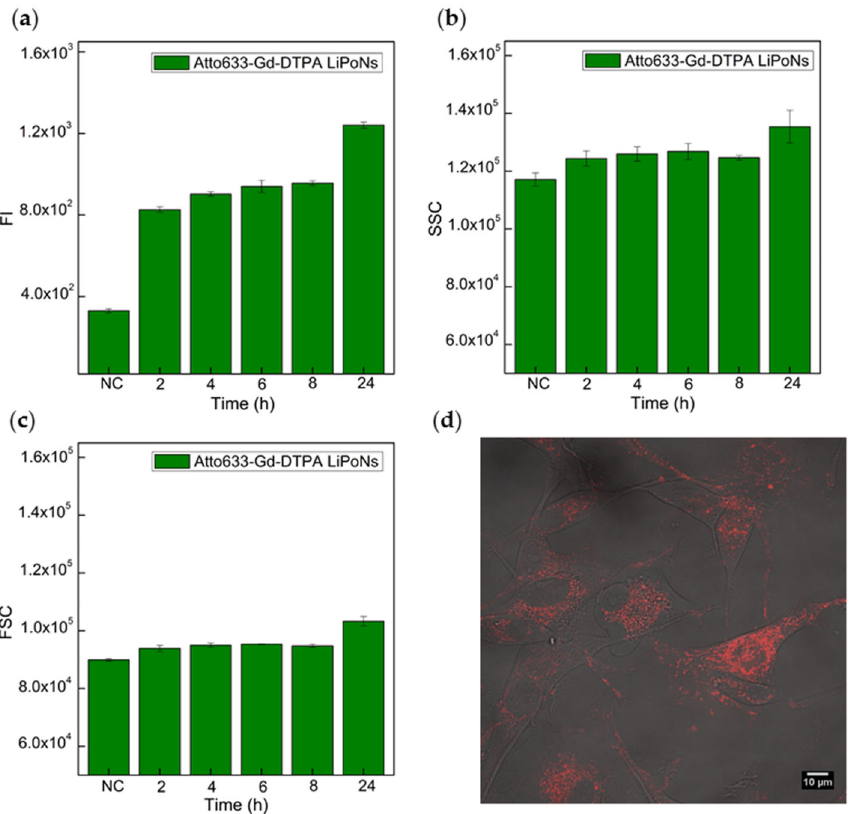
Figure 7. Quantitative uptake of multimodal imaging LiPoNs by U87 MG cells: ( a ) Fluorescent Intensity (FI); ( b ) Side Scattering Area (SSC); ( c ) Forward Scattering Area (FSC) of U87 MG cells exposed to Atto633-Gd-DTPA co-loaded LiPoNs (Lipids conc.: 90 µ g/mL, Atto 633 conc.: 0.6 µ g/mL, Gd-DTPA conc.: 225 µ M) for different time points: 2 h, 4 h, 6 h, 8 h and 24 h. ( d ) Merge image of the transmission and fluorescence (Atto633) images obtained by confocal microscopy of U87 MG cells treated for 24 h with the 90 μ g/mL of Atto633 ‐ Gd ‐ DTPA LipoNs.